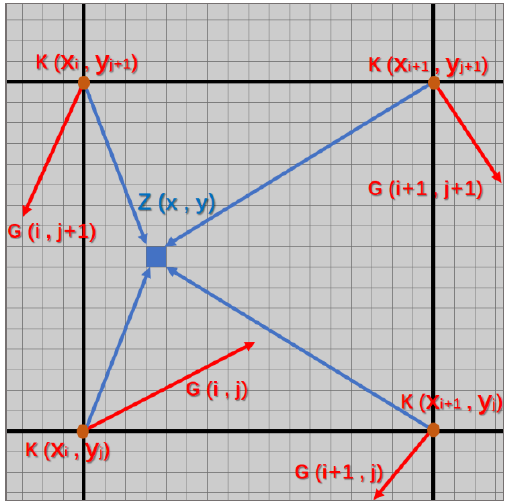
Figure 12. Illustration of noise calculation.